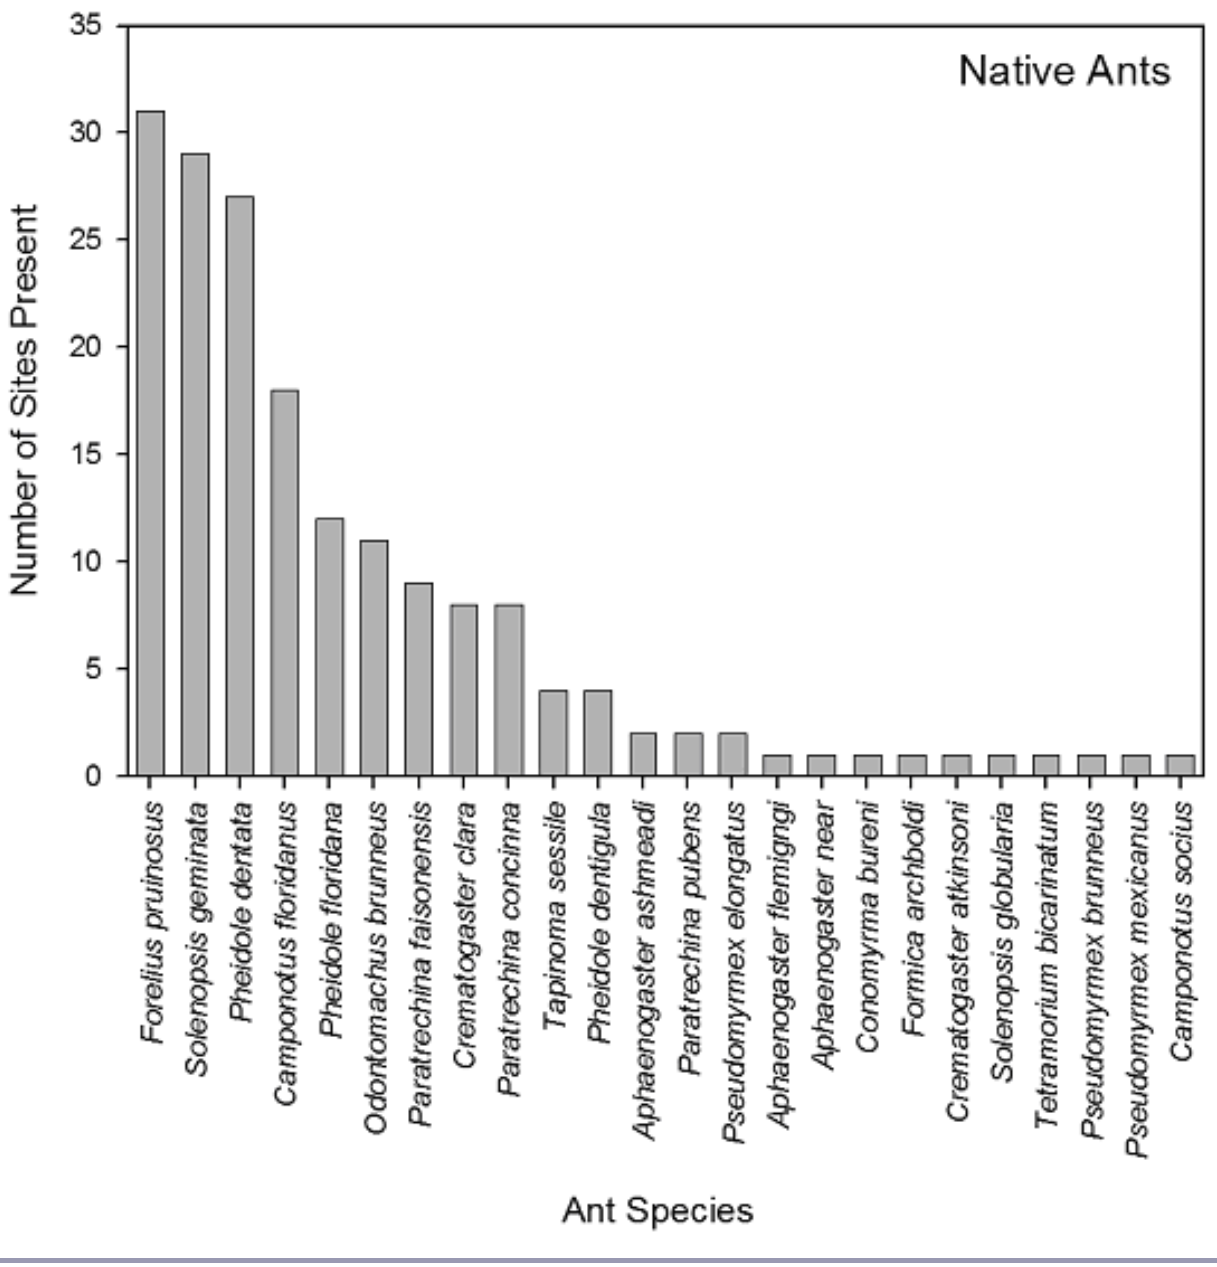
Fig. 2. The number of sites in the Lower Florida Keys that had each native species